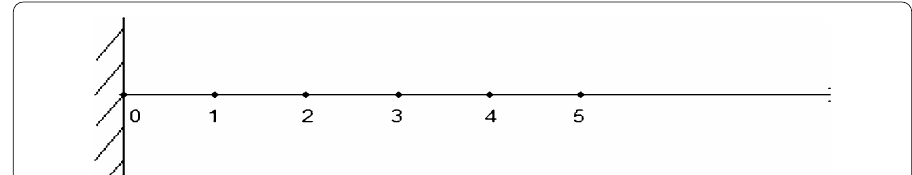
Figure 2 Grid point discretization for the left